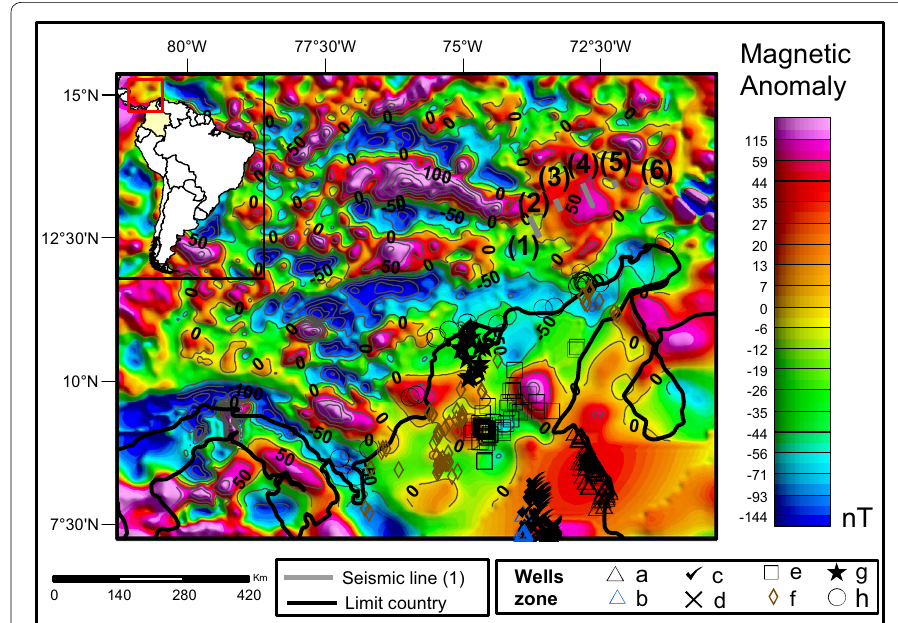
Fig. 2 Total field magnetic anomalies of the study area. Database taken from the World Magnetic Anomaly Map V2 (Lesur et al. 2016). Short gray lines indicate location of seismic lines used to calculate the geothermal gradient by means of the Bottom Simulator Reflector (BSR) method. Symbols indicate location of used Bottomhole Temperature (BHT) and the attached letters to them refers to respective differences between the calculated gradient by the fractal method and the gradient estimated from BHT, presented in Fig. 9. The upper left inset shows the location of the study zone within South